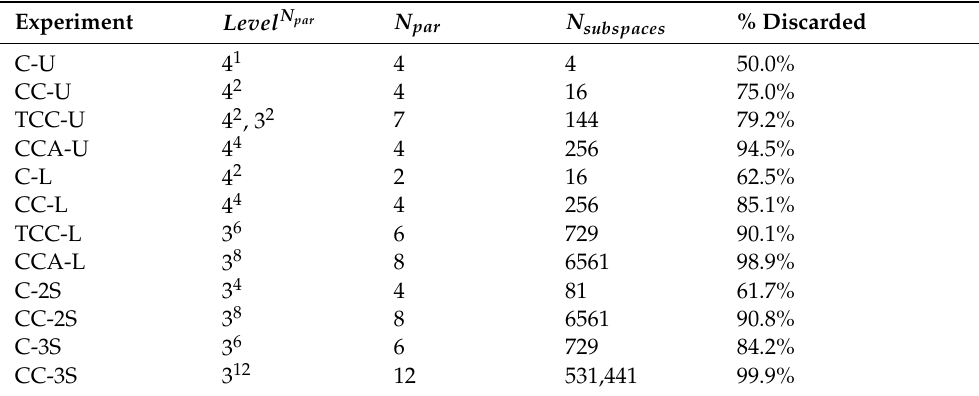
Table 7. Number of discarded subspaces.